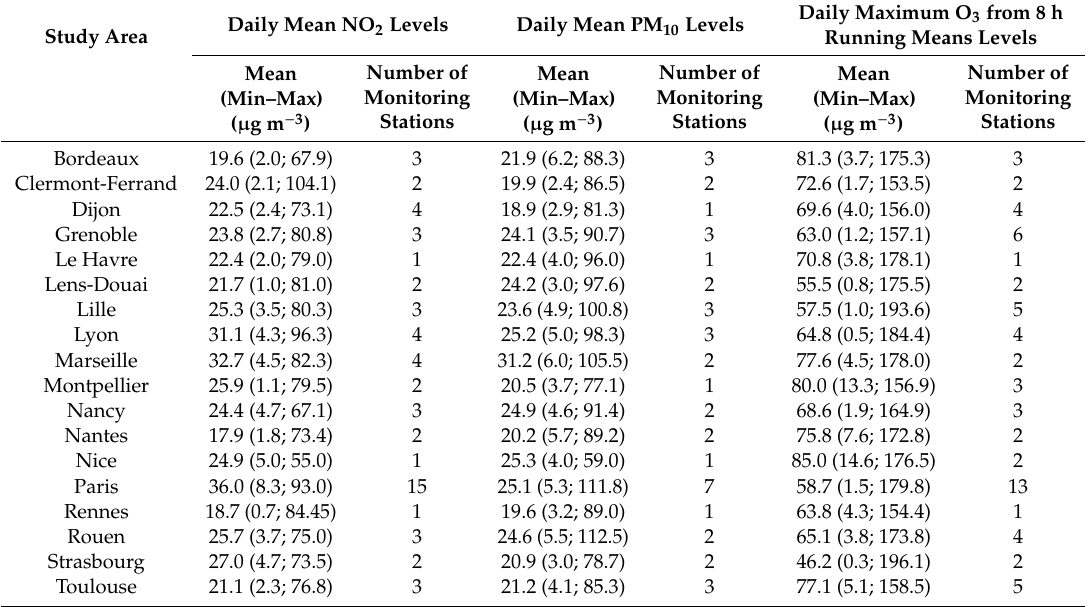
Table 1. Mean levels of air pollution indicators and the number of monitoring stations considered to build the exposure indicator, according to study area: